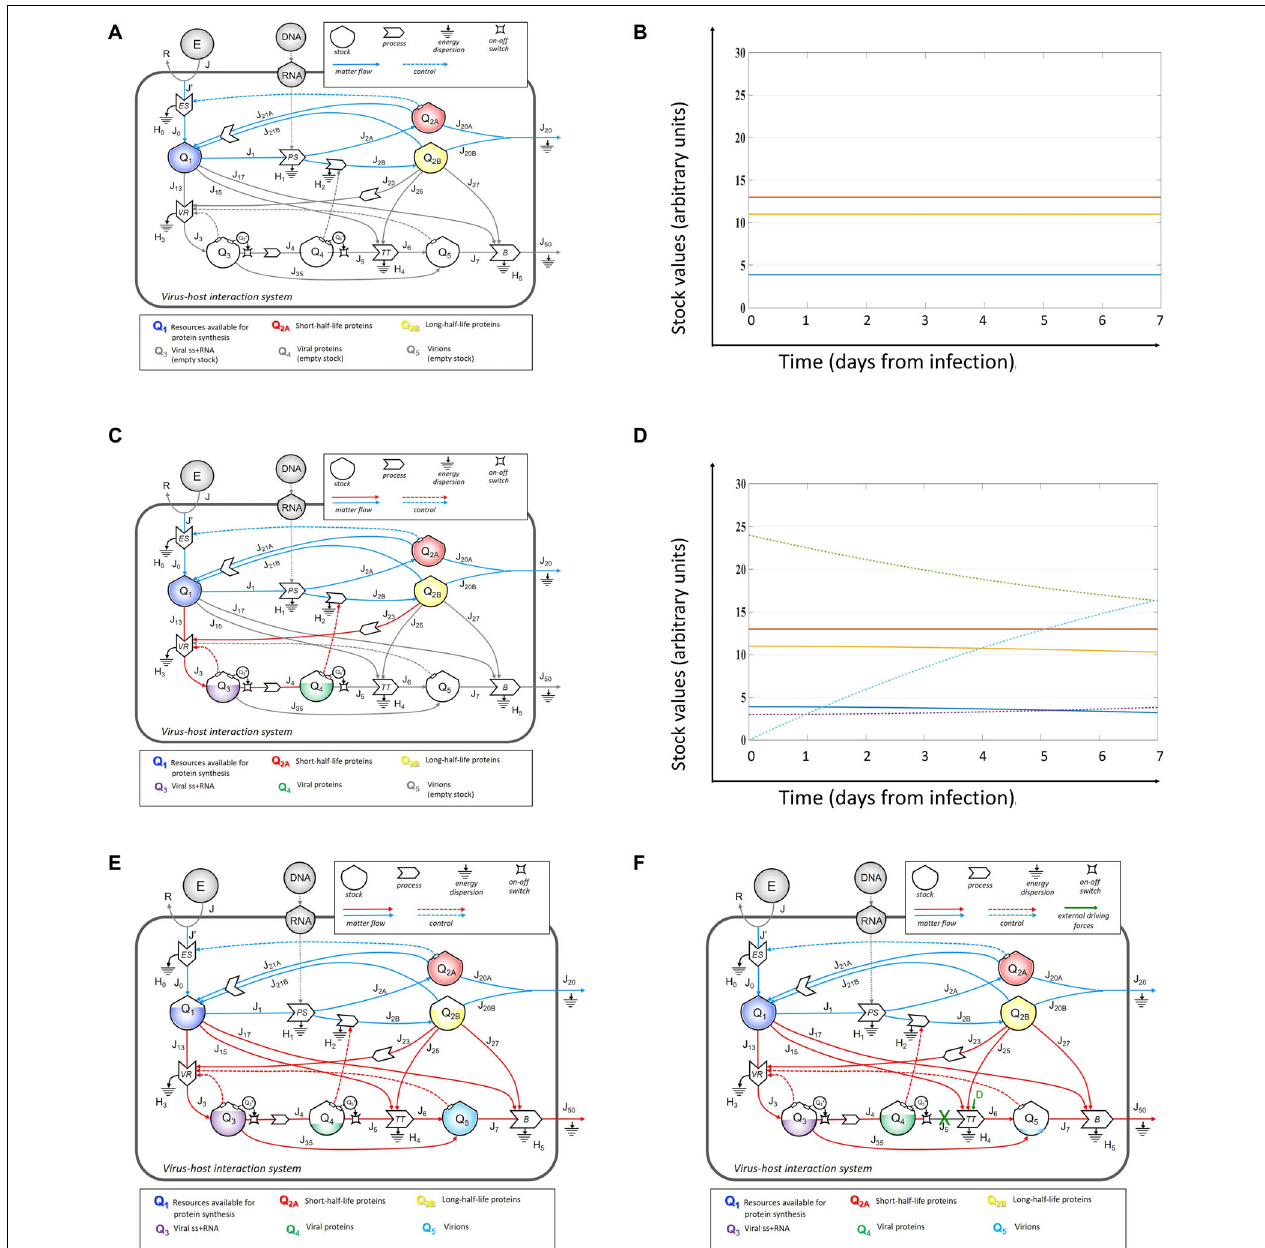
FIGURE 2 | Systems configurations based on initial conditions and effects of external driver forces. In the configuration of initial null viral load (A) , the value of stocks Q 1 , Q 2 A , and Q 2 B were constant, and the system behavior was stationary (B) , with constant values of all stocks overtime. At time of infection, the network of flows and feedbacks identified a new configuration (C) , to generate a not stationary pattern (D) , in which stock values change overtime in response to the other elements